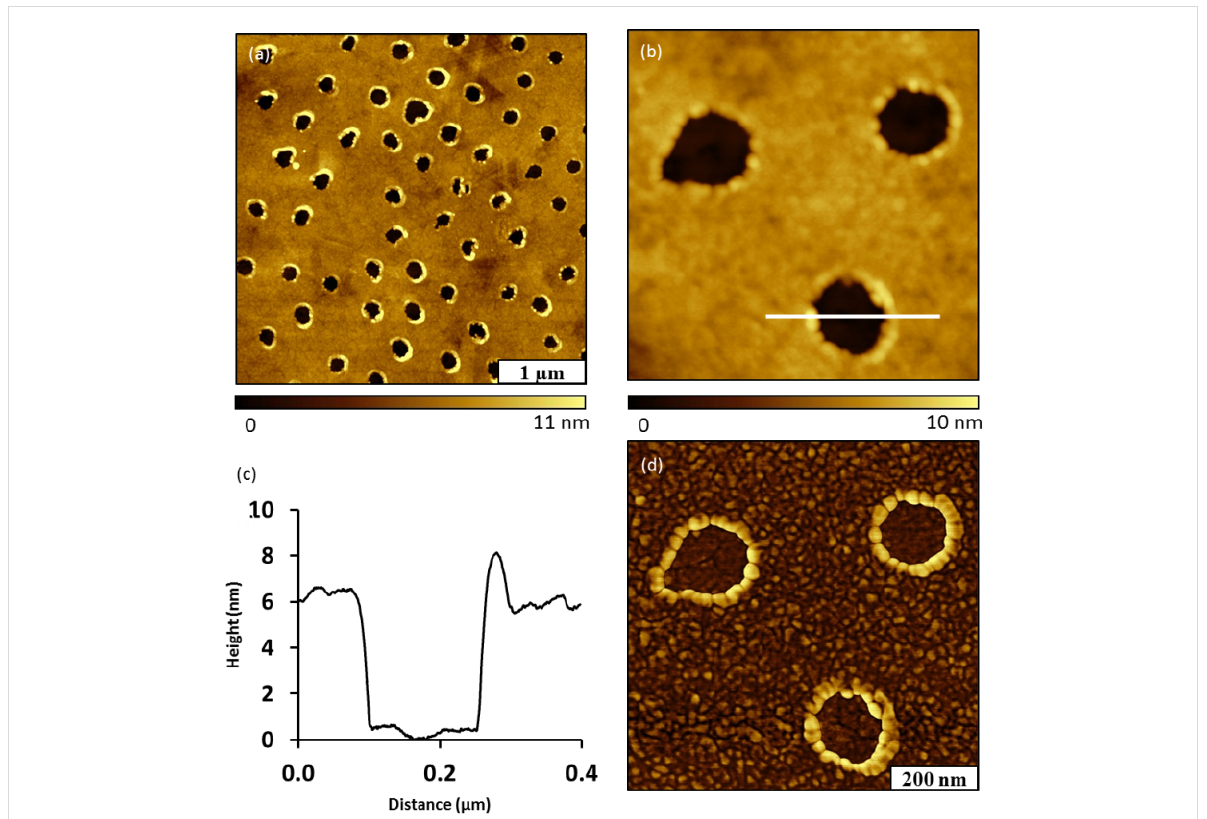
Figure 4: Film of Au–NHBoc prepared on Au(111) with nanopores using particle lithography. (a) Topograph of nanopores; (b) zoom-in topography view of nanopores; (c) cursor profile for the line in (b); (d) corresponding phase image of (b).